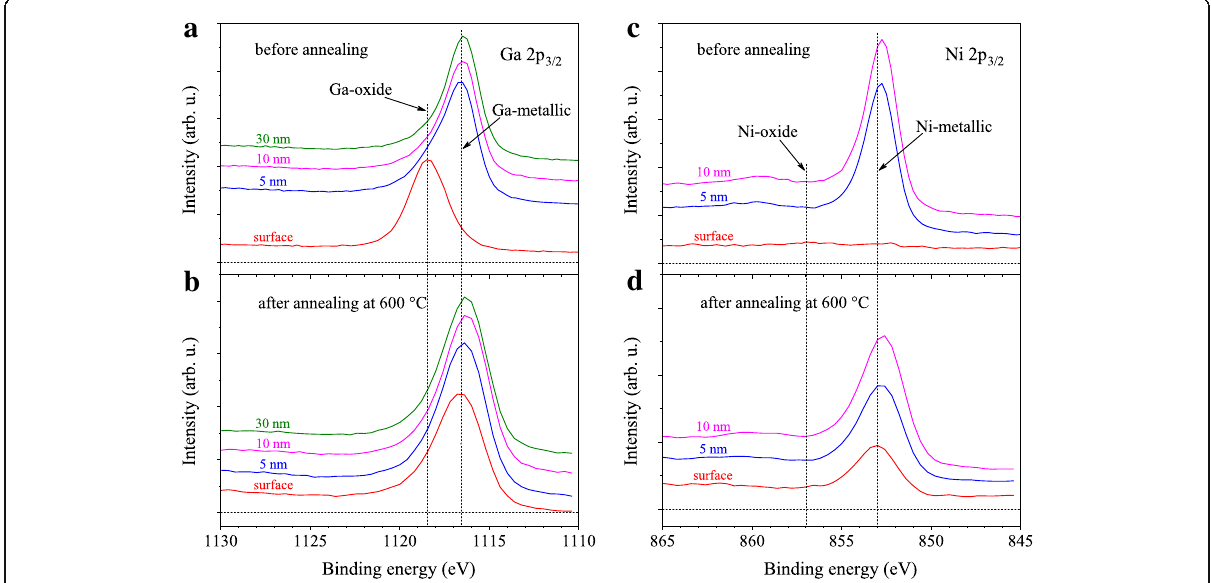
Fig. 7 Ga 2p 3/2 XPS high-resolution spectra at several depths between the surface and 30 nm at 25 °C of a the Ga 3 Ni 2 oxidized monocrystalline surface (prior to the annealing experiments) and b after annealing at 600 °C. The corresponding Ni 2p 3/2 spectra of c the oxidized surface and d after annealing at 600 °C. The spectra are not